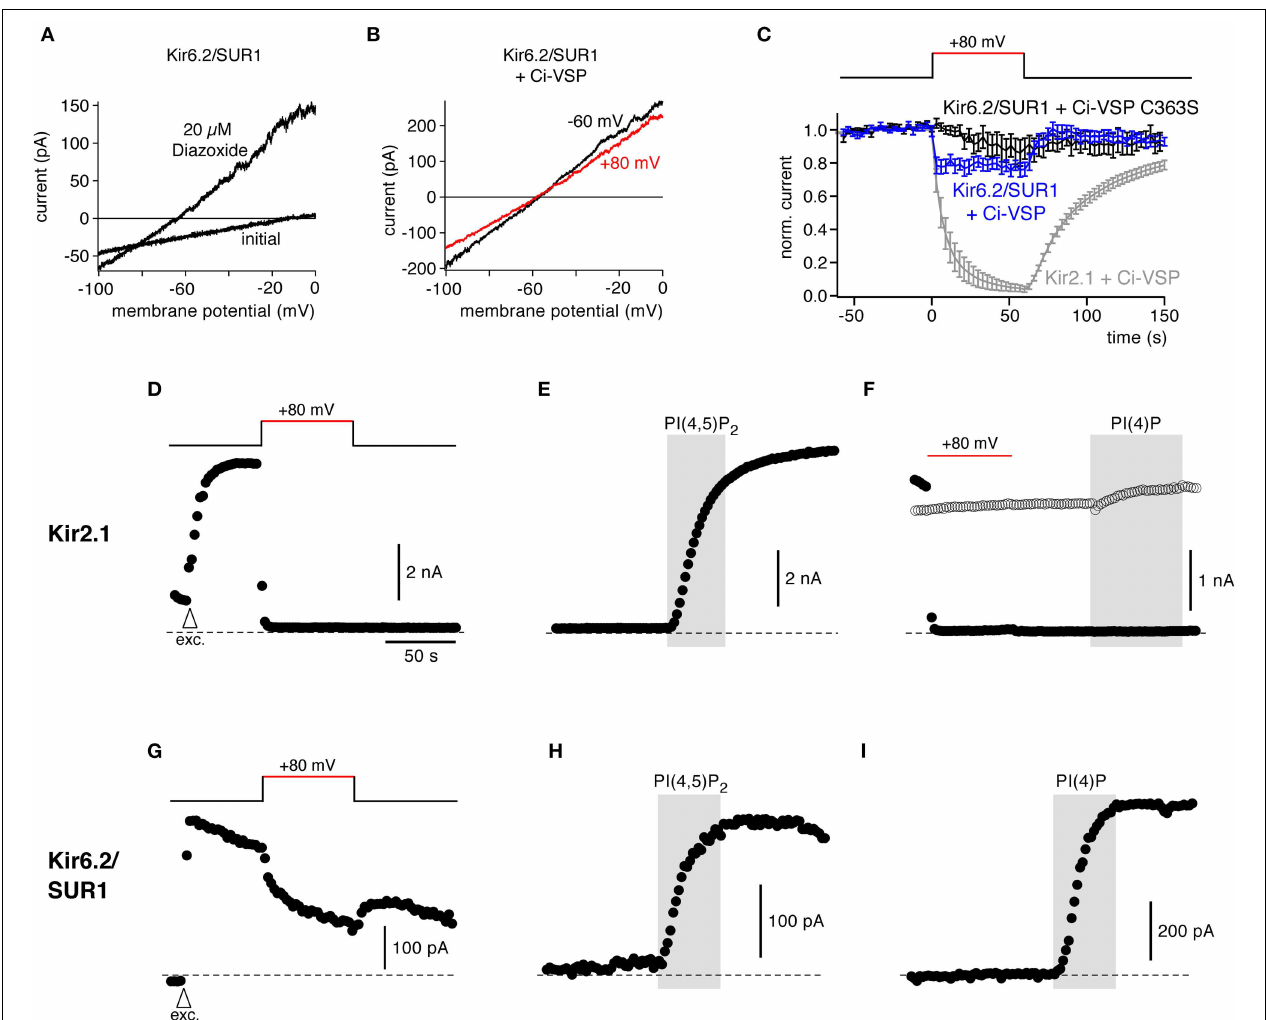
FIGURE 4 | Response to Ci-VSP is determined by PI selectivity, as revealed by the insensitivity of Kir6.2/SUR1 channels. (A) Representative current recordings from a CHO cell expressing Kir6.2/SUR1. Channels were activated with 20 µ M diazoxide in the presence of intracellular ATP, and currents were recorded in response to voltage ramps from − 100 to 0mV. (B) Kir6.2/SUR1 currents (with diazoxide) from a cell co-transfected with Ci-VSP without (black, holding potential − 60mV) and during (red, + 80mV) depolarization-dependent activation of Ci-VSP. (C) Time course of Kir6.2/SUR1 currents during depolarization of the holding potential recorded as in (B) in cells co-expressing either wild type Ci-VSP (blue) or catalytically inactive Ci-VSP (C363S) (black). Shown are mean outward currents at 0mV to minimize influence of any leak currents, normalized to current amplitude before depolarization ( ± SEM, N = 12 and 10 cells, respectively). Activation of Ci-VSP had little effect on Kir6.2/SUR1 channels. Strong inhibition of Kir2.1 currents under the same experimental conditions is